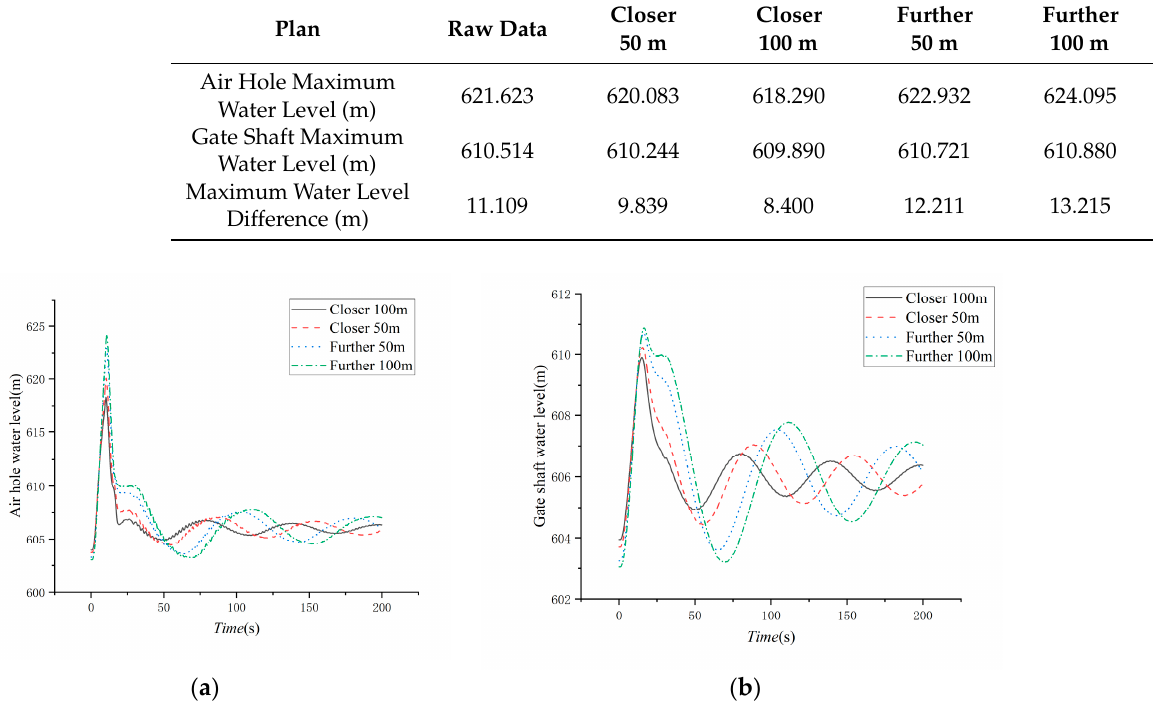
Figure 10. Curves of water level of air hole and gate shaft by different gate shaft layout methods: ( a ) air hole and ( b ) gate shaft.